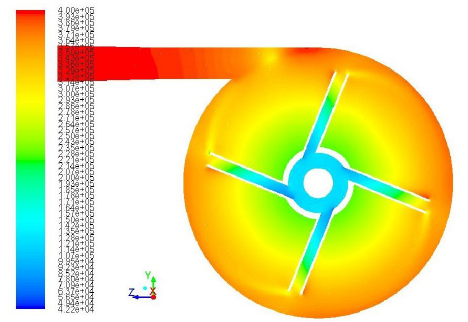
Figure 16: Static pressure distribution [Pa] in Impeller 3